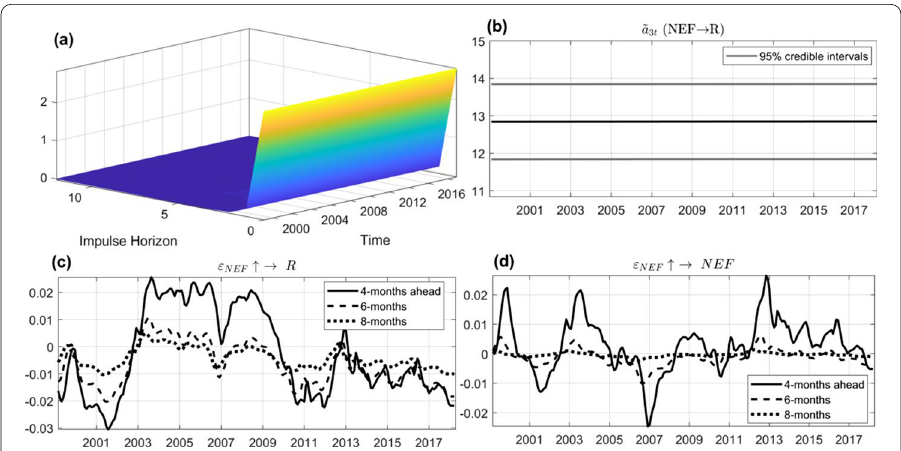
Fig. 4 Time-varying impulse responses of stock returns. a) The historical impulse response functions of stock returns b) The contemporaneous response of stock returns c) Time-varying response of returns to net